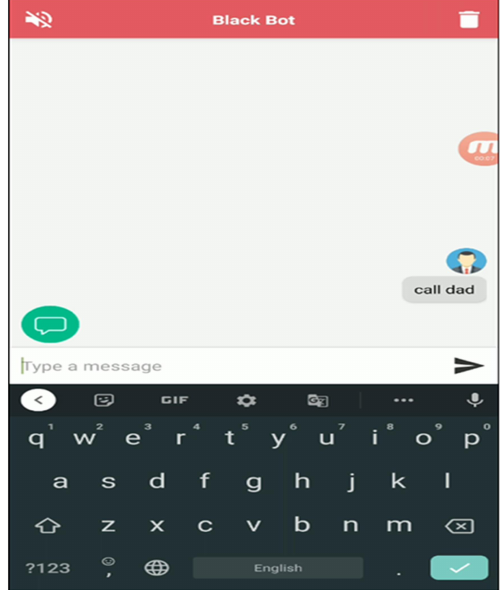
Fig 6 User command to chatbot via speech